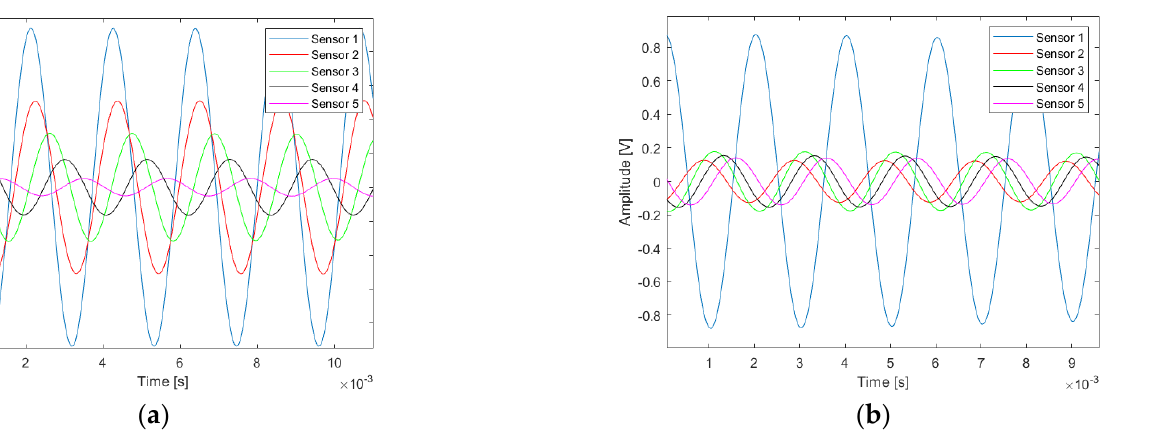
Figure 14. Example of real received signals digitally filtered between 480 and 520 Hz: ( a ) corresponding to Model M1; ( b ) not corresponding to Model M1.